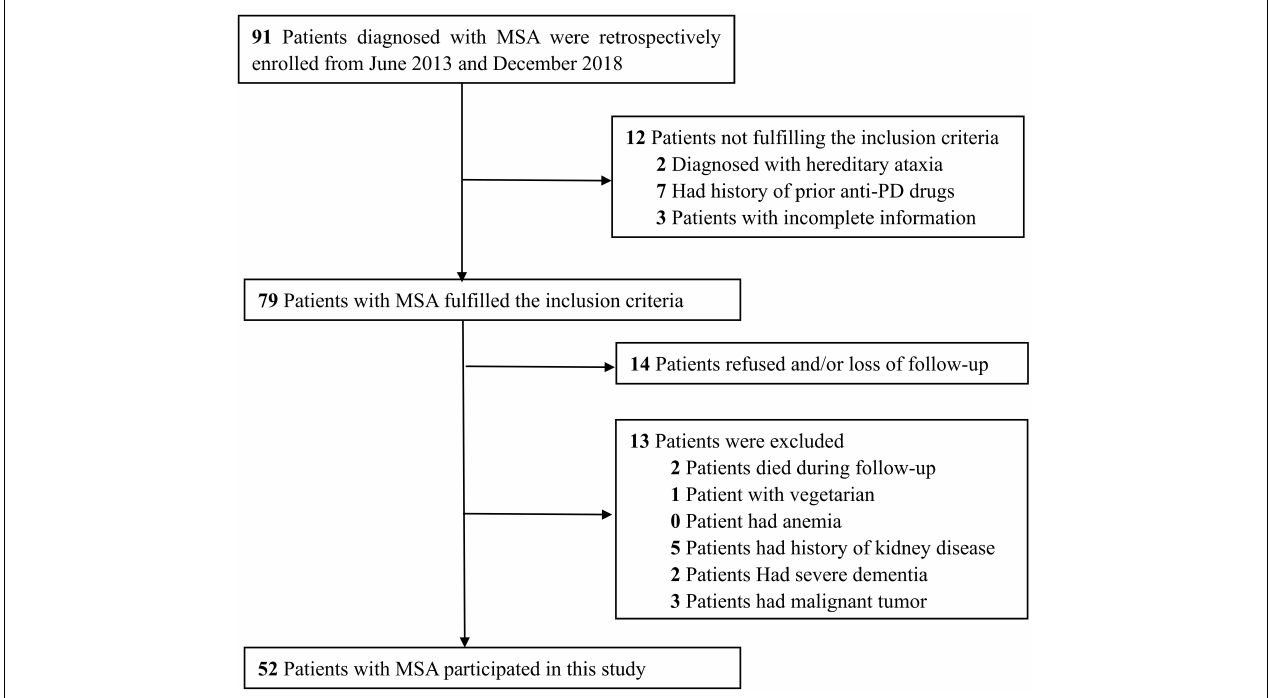
FIGURE 1 | Flow chart presenting the process of patient inclusion and exclusion of this study.